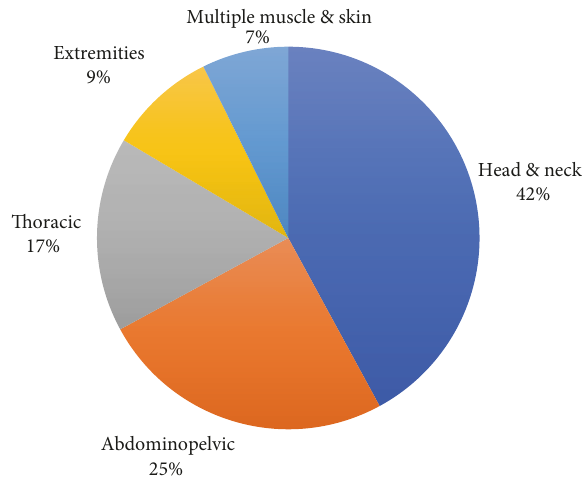
Figure 2: Unexpected ECM strati fi cation according to anatomical site spread.